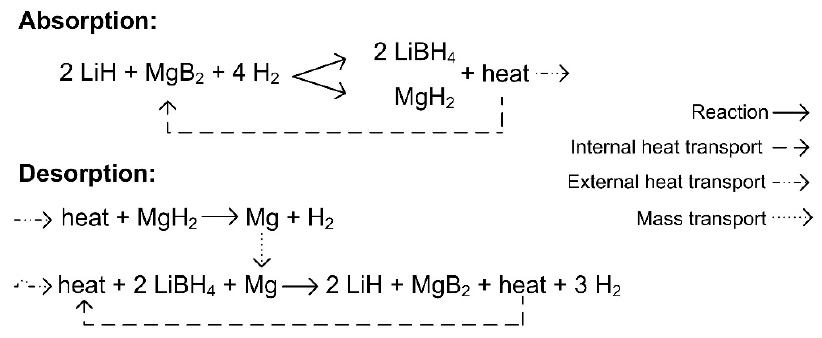
Figure 10. Schematic reaction mechanism proposed for the single-step absorption and the two-step desorption processes. desorption